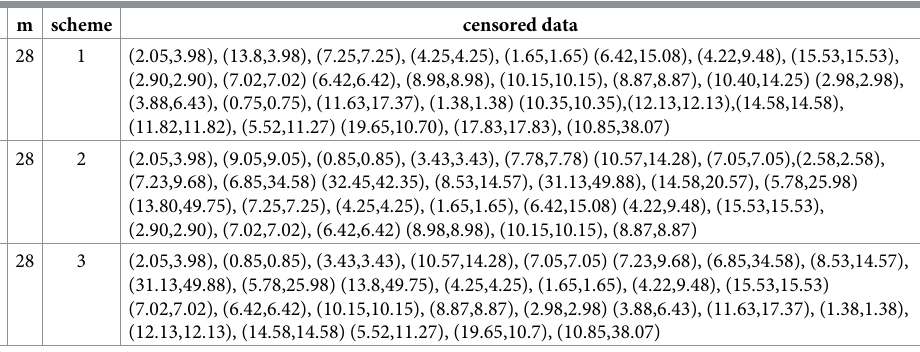
Table 8. Censored American Football league.